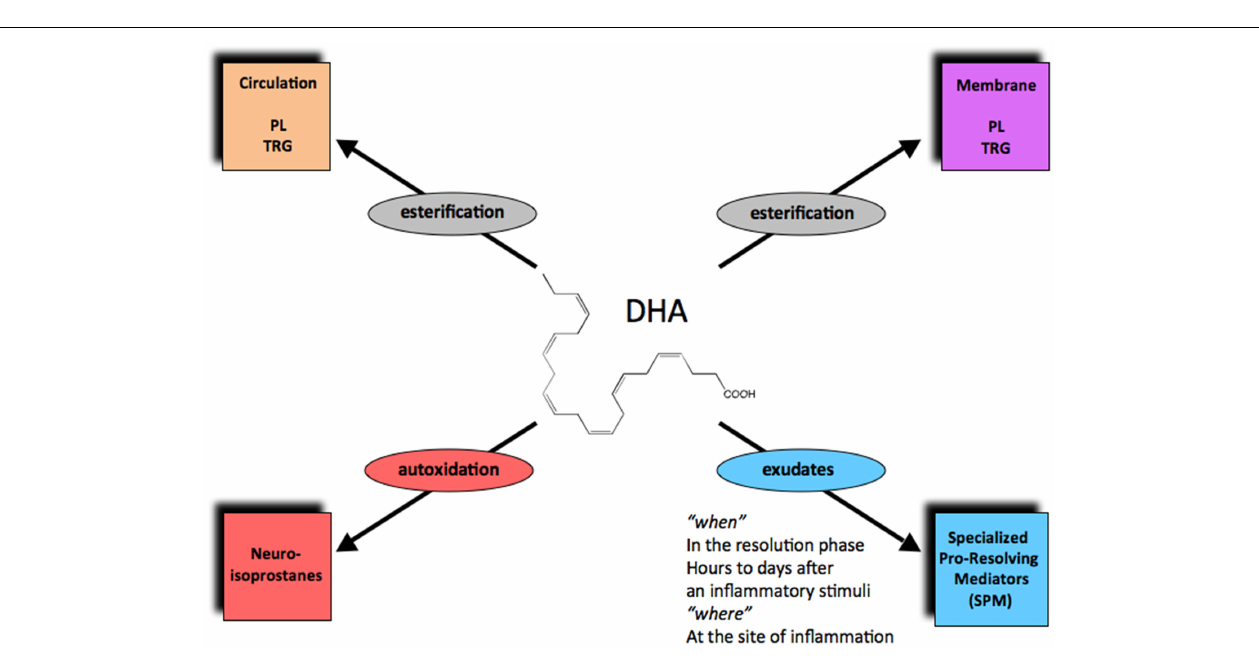
neuroisoprostanes, the DHA form of isoprostanes. Enzymatic conversion in local inflammatory exudates can generate the specialized pro-resolving lipid mediators (SPMs), including D-series resolvins, protectins, and